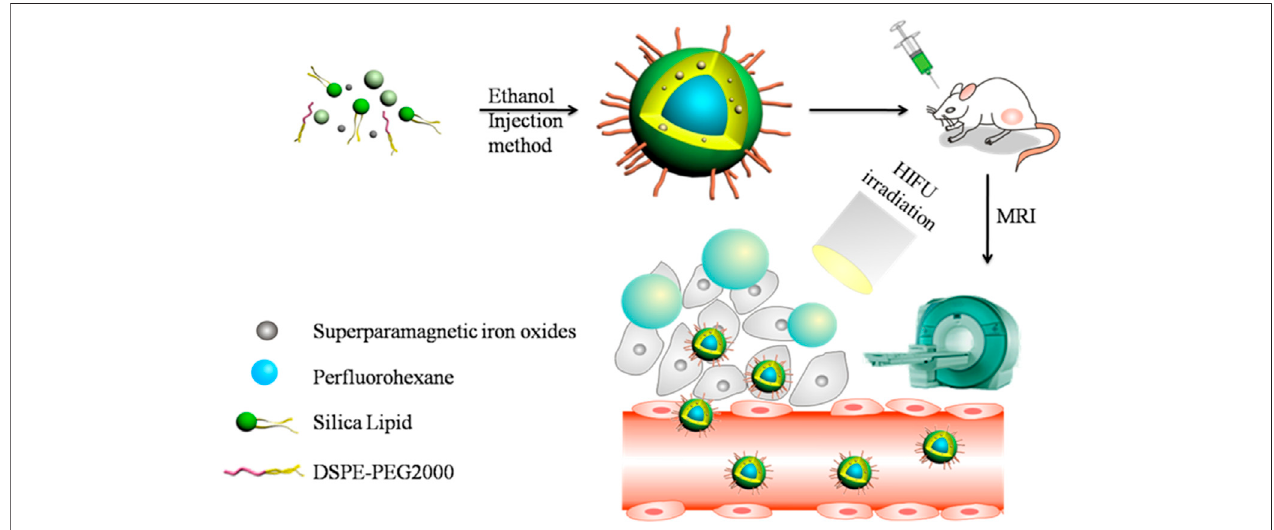
FIGURE 1 | Schematic illustration of SSPN and “ liquid-to-gas ” phase transition